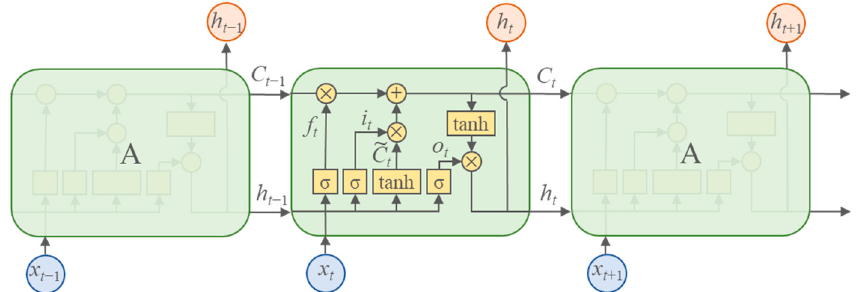
Figure 3. LSTM network structure.